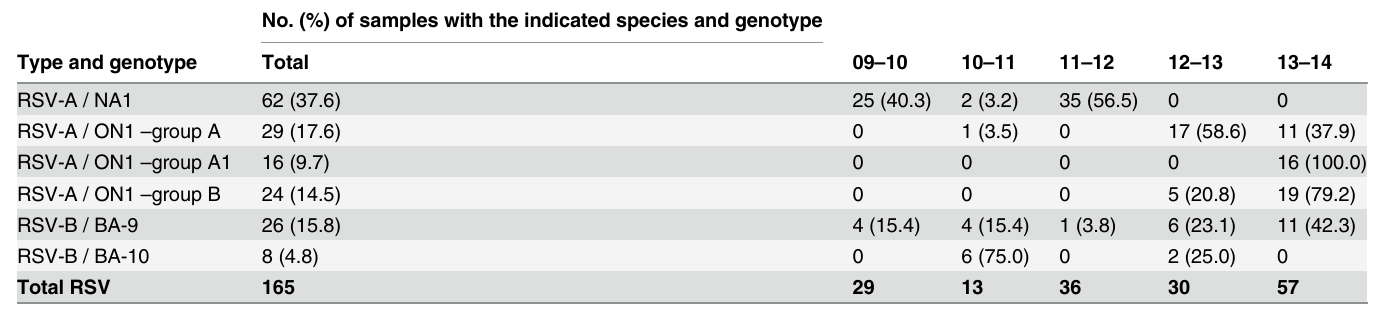
Table 2. RSV types and genotypes detected in the studied nasopharyngeal samples. No. (%) of samples with the indicated species and